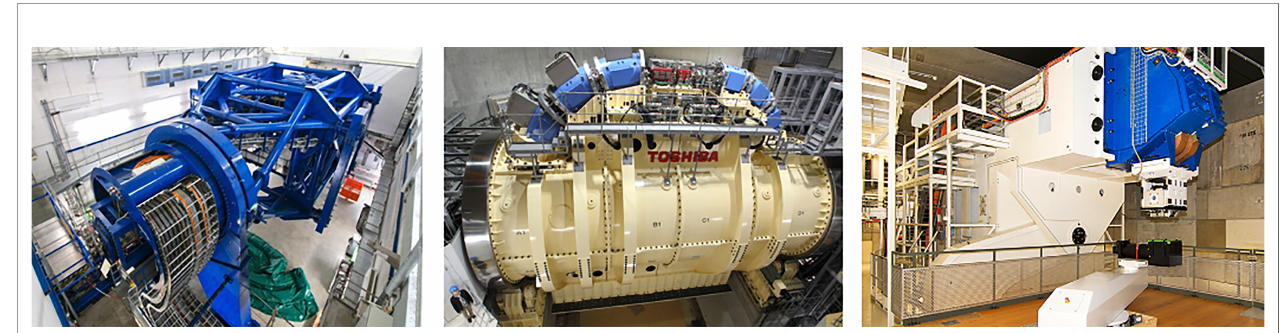
FIGURE 8 | Gantry installations at HIT (106) and HIMAC, QST (104) for CIBT. PSI PBT Gantry 2 (Photo: Paul Scherrer Institute/Markus